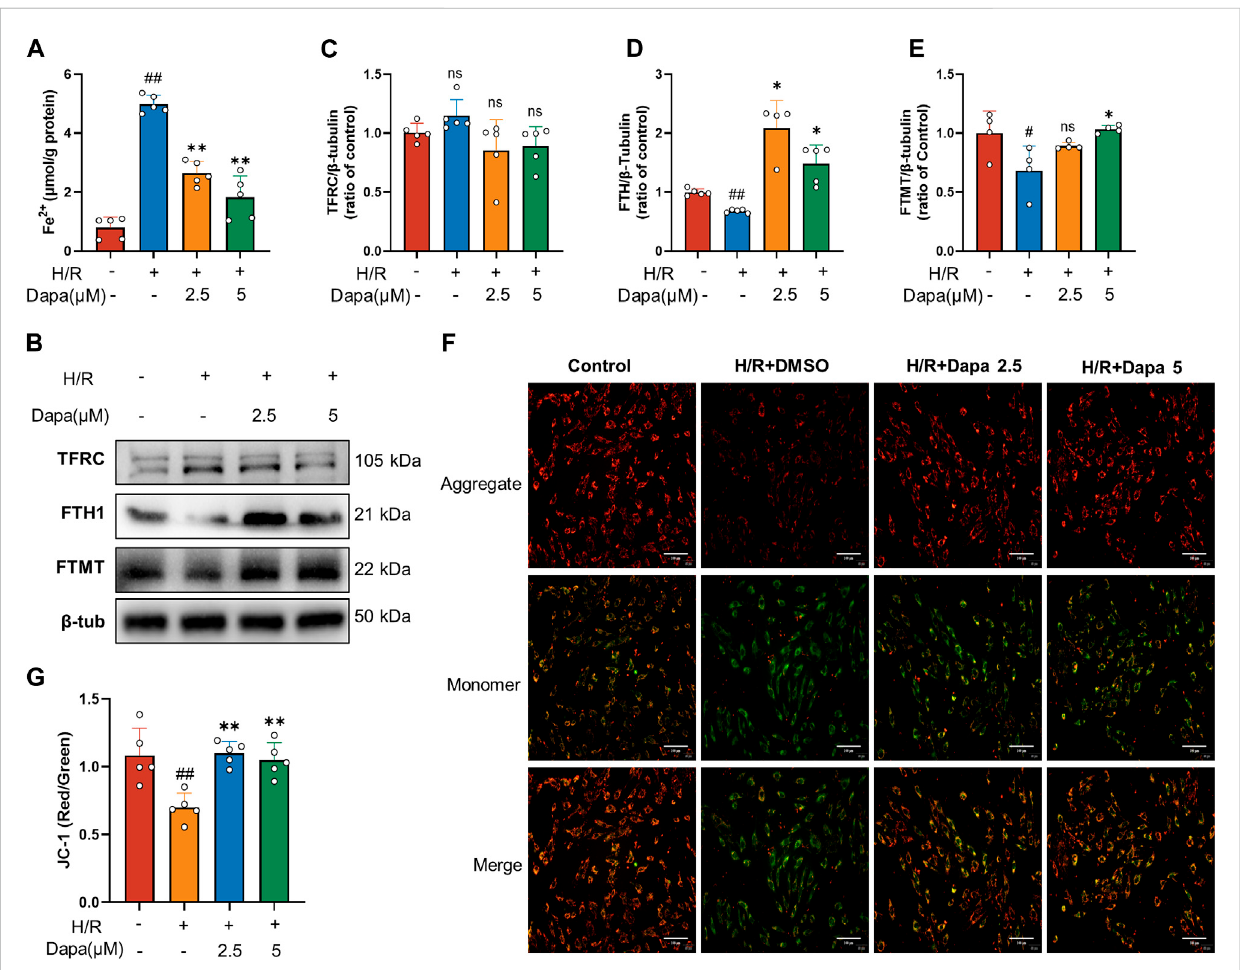
FIGURE 4 Dapagli fl ozin regulates intracellular iron metabolism and mitochondrial function. (A) Intracellular Fe 2+ accumulation was assayed by a commercial kit ( n = 5 per group). (B – E) The protein levels of TFRC, FTH1 and FTMT were measured by western blotting and quantitative analyses ( n = 4, 5 per group). (F,G) Representative fl uorescence images ofJC-1 stainingand quantitative analyses accordingto theredoptical density/greenoptical density (scalebar, 100 μ m, n =5per group).Data are expressed as mean± SD;One-way ANOVA followedbyTukey ’ scorrection for post hoc multiple comparisons or Dunnett ’ s multiple comparison tests; # p < 0.05, ## p < 0.01 vs Control group; * p < 0.05, ** p < 0.01 vs H/R